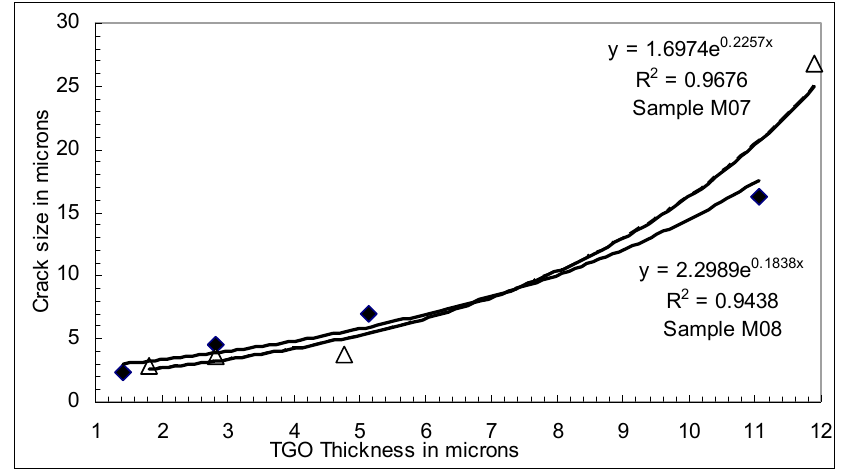
Figure 5. Exponential relationship between two forms of physical damages associated with thermal cycling in TBC. Symbol ∆ represents low pressure oxygen coating and symbol (cid:7) represents air plasma coating.